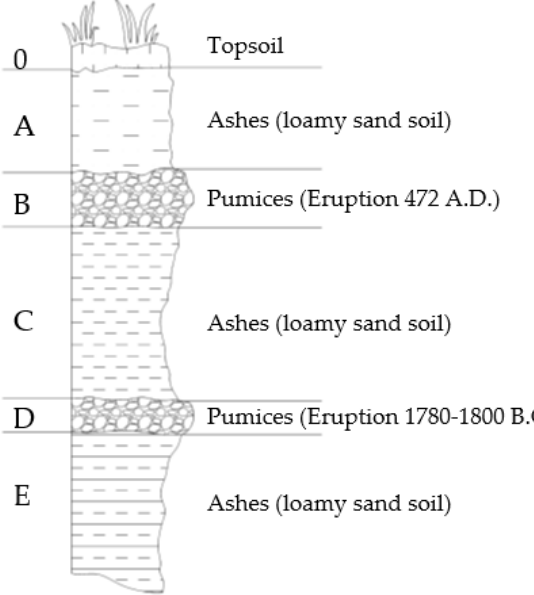
Figure 1. Sketch of the layered soil profile in the site of sample collection.